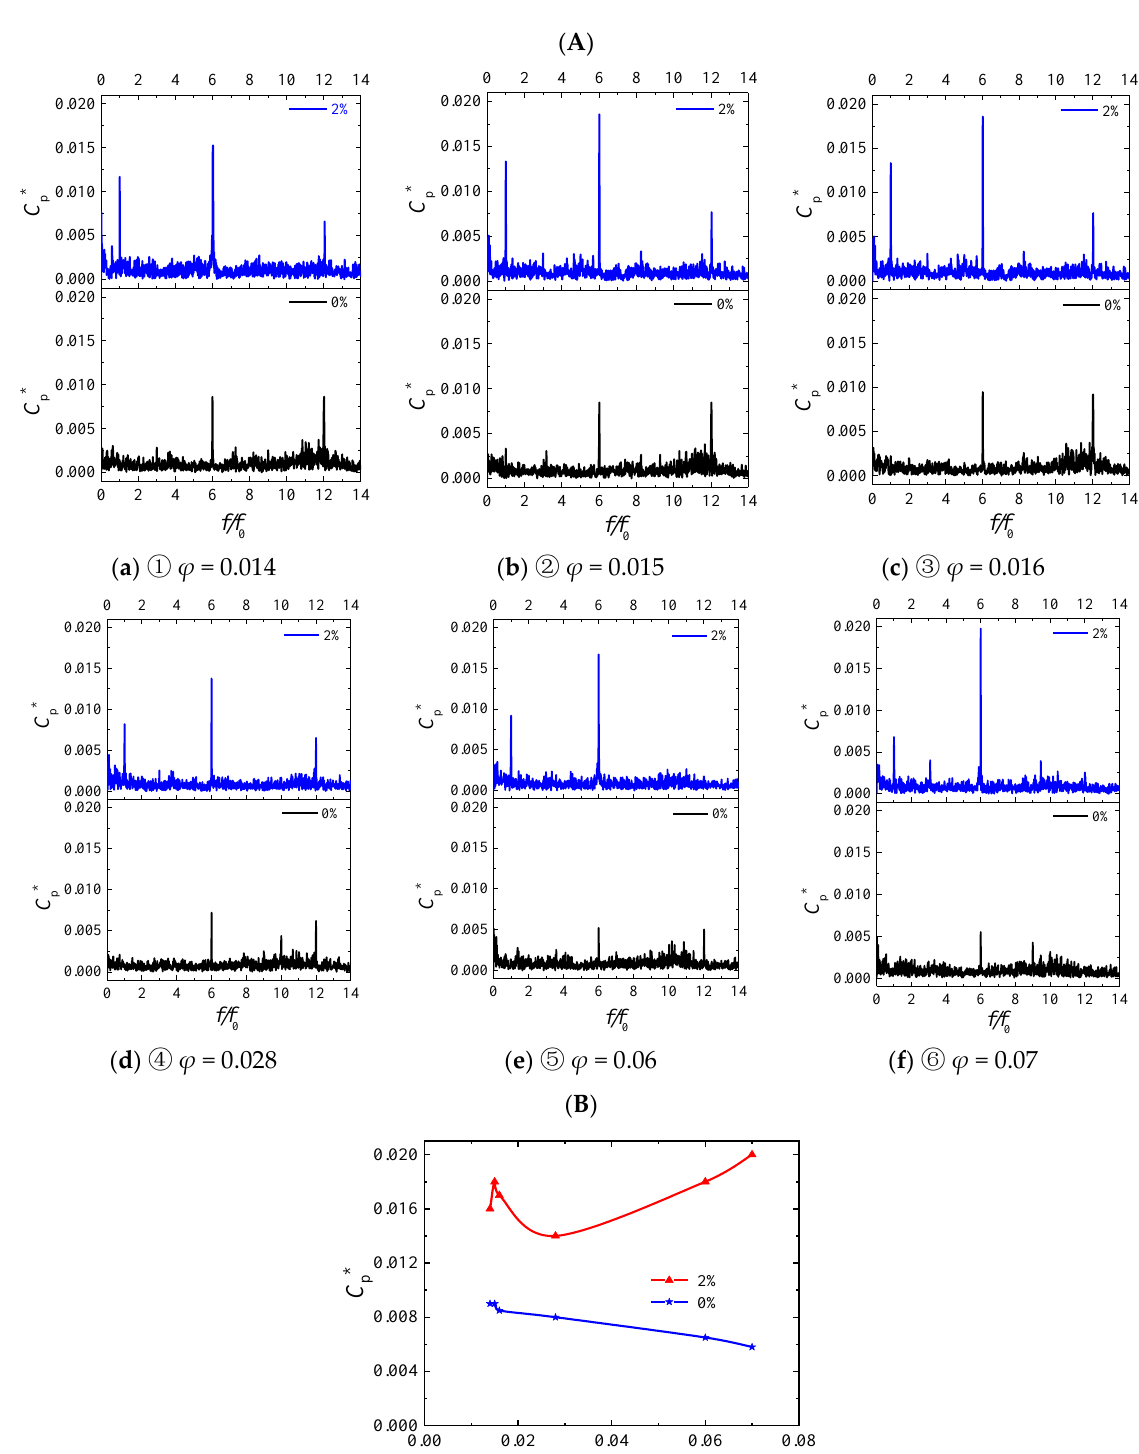
Figure 6. Pump performance head coefficient versus flow coefficient for α = 0% and 2%.